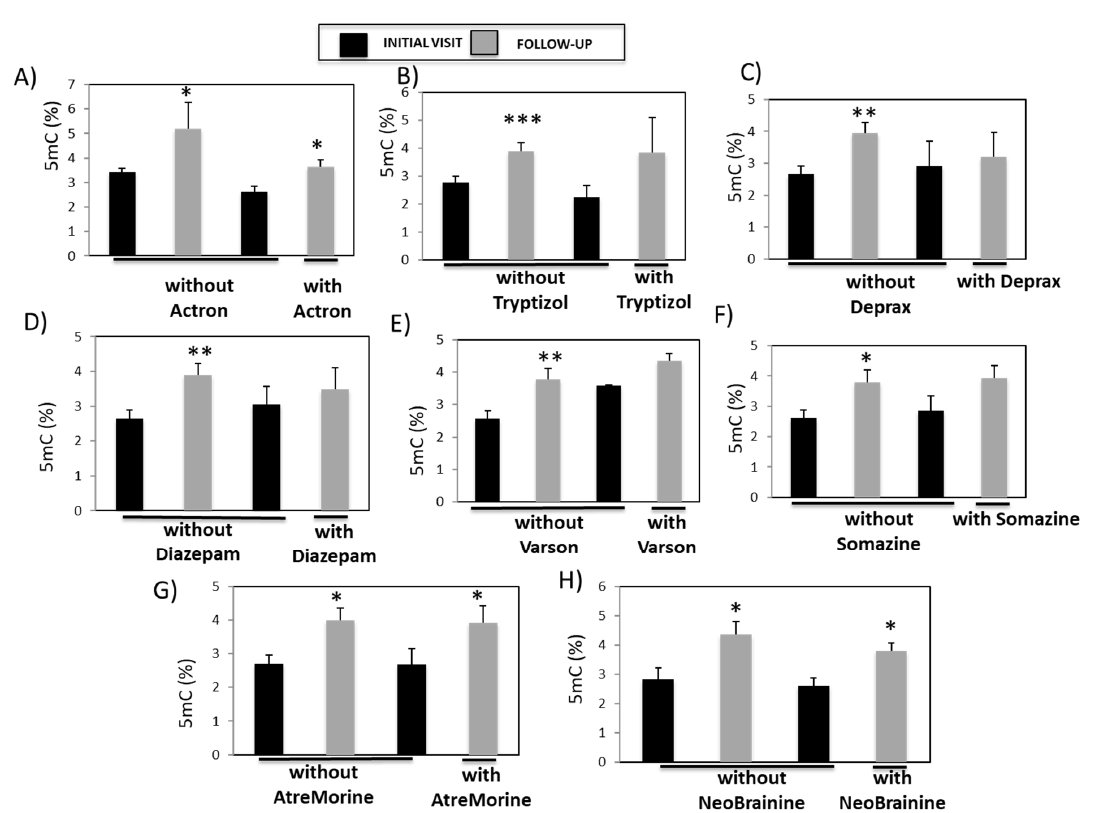
Figure 9. The relationship between pharmacotherapies for brain disorders and global DNA methylation in patient serum samples. Global DNA methylation levels were compared in patients whose 5mC levels were higher during the follow-up than during the initial visit and who were, or were not, treated with ( A ) Actron, ( B ) Tryptizol, ( C ) Deprax, ( D ) Diazepam, ( E ) Varson, ( F ) Somazine, ( G ) AtreMorine TM , and ( H ) NeoBrainine ® . Data are presented as the mean ± S.E.M; one way ANOVA and Bonferroni post hoc test (* p < 0.05; ** p < 0.01; *** p < 0.001). 5mC, 5 ‐ methylcytosine.